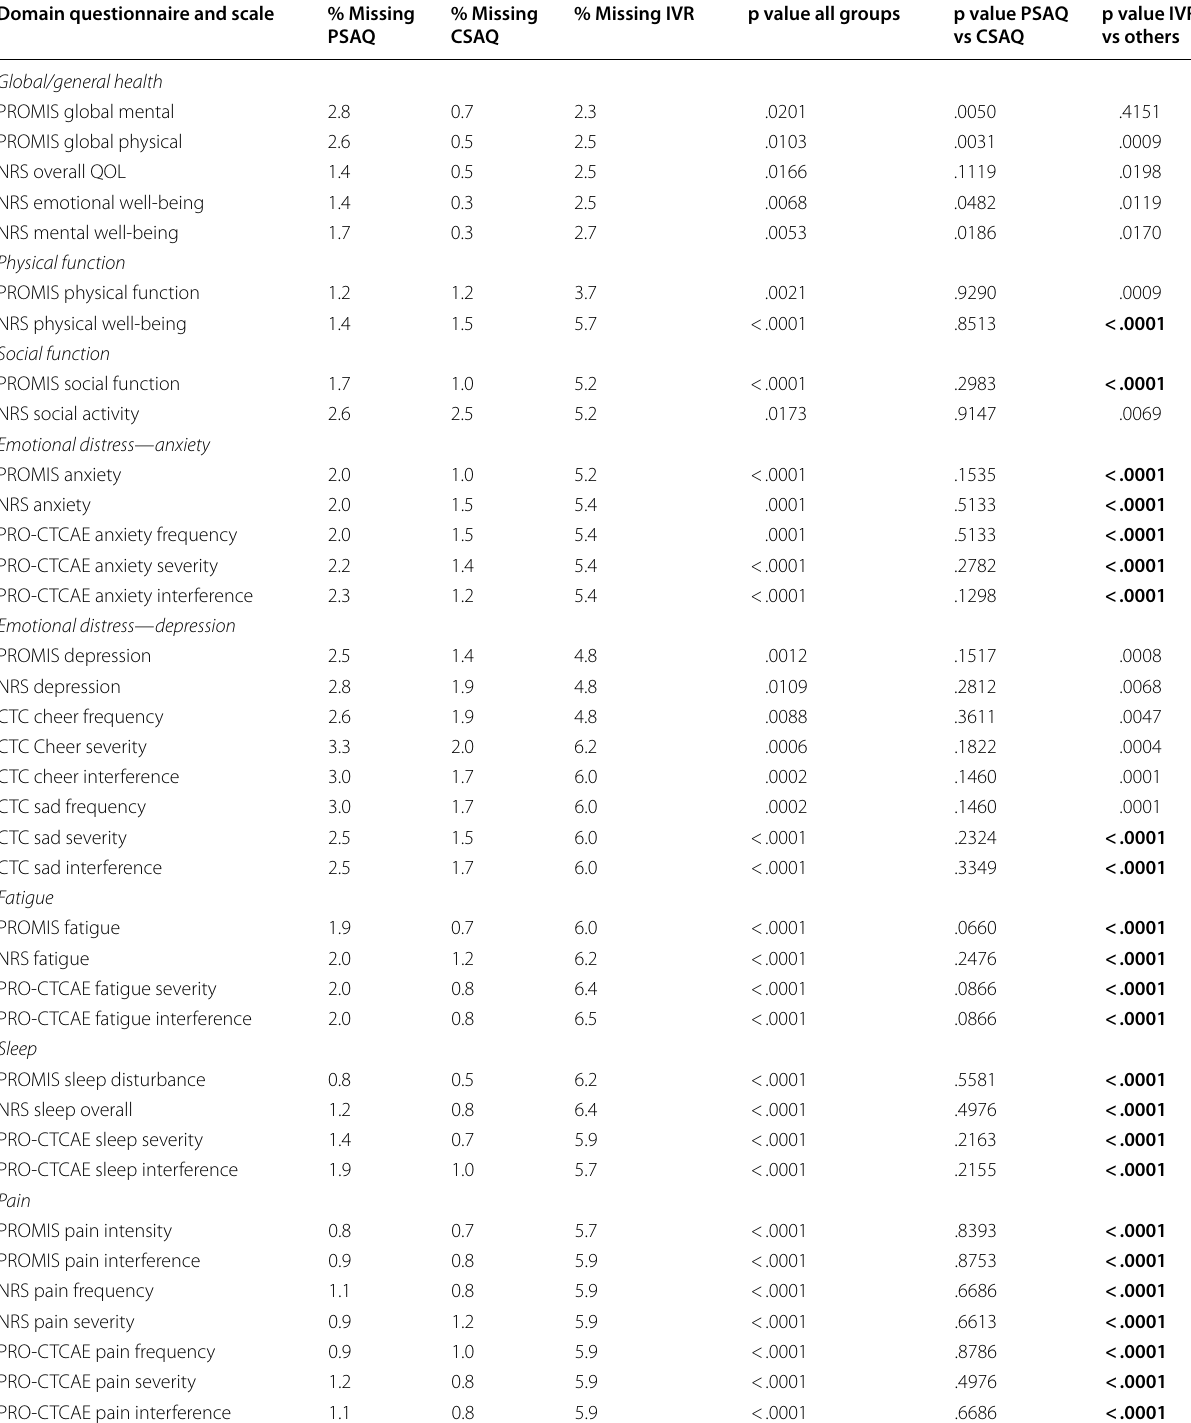
The equality of proportion tests with χ 2 test statistic were used to derive the p values. Because of multiple comparison concerns, p < .0001 will be used as a guideline to identify likely significant differences